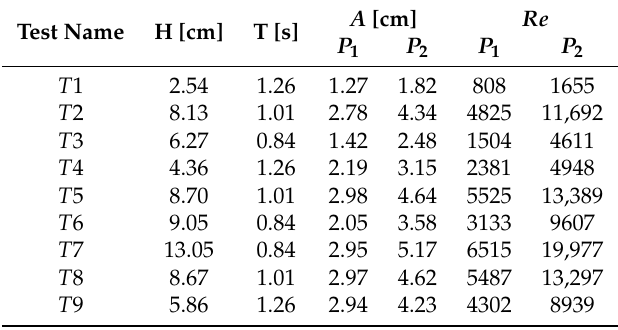
Table 1. Experimental conditions and main Hydrodynamics